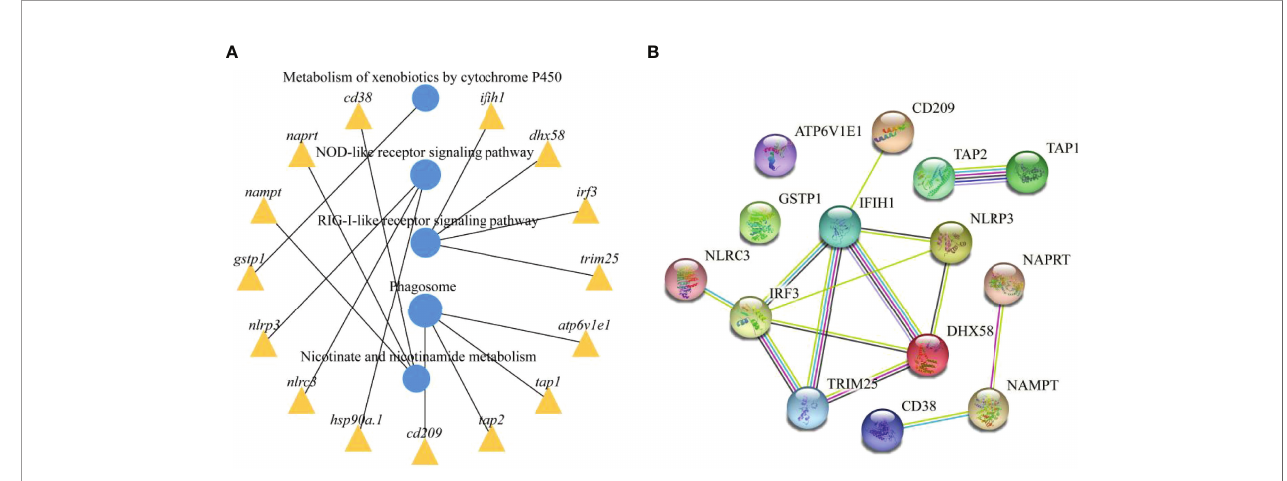
FIGURE 6 | Immune and metabolism-related pathways and genes interactions. (A) Enrichment of DEmRNAs in corresponding pathways and interaction of immune and metabolism-related pathways. (B) PPI network analysis of the immune and metabolism-related genes identi fi ed in this study based on STRING